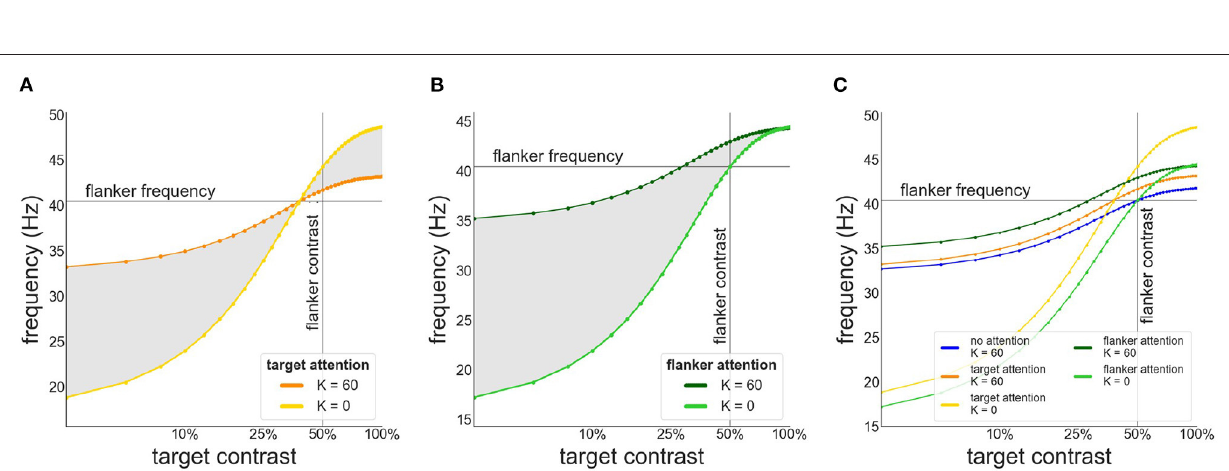
Frontiers in Systems Neuroscience |